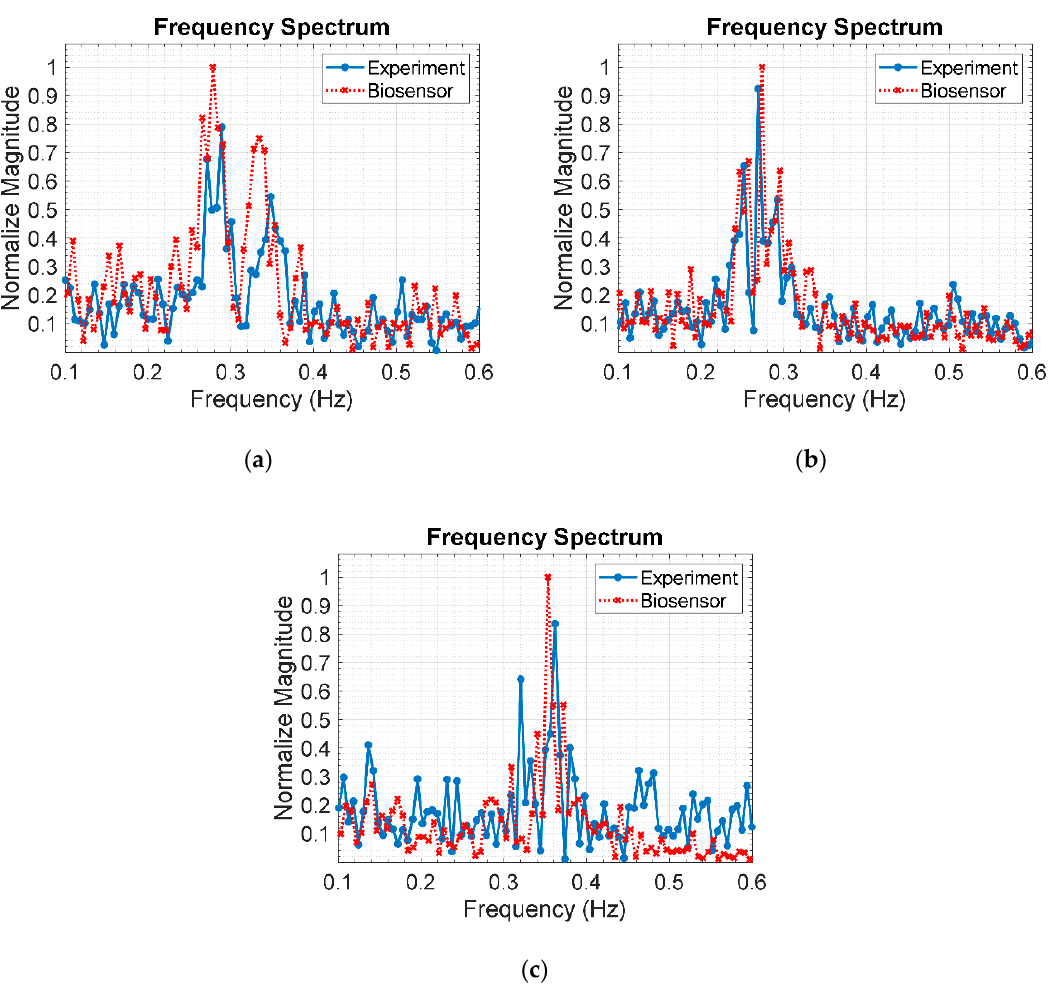
Figure 17. Respiratory frequency of a human subject in prone position under layers of stacked clay bricks, using IR-UWB radar system and respiration sensor: ( a ) 3 layers (9 cm); ( b ) 6 layers (18 cm); ( c ) 9 layers (27 cm).